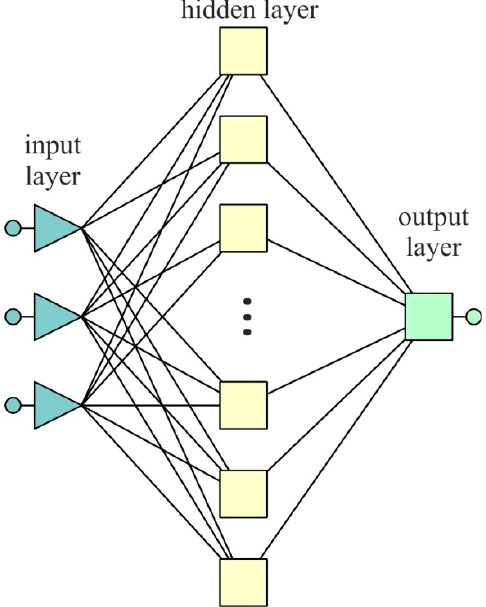
Figure 3. The architecture of the multilayer ANN.